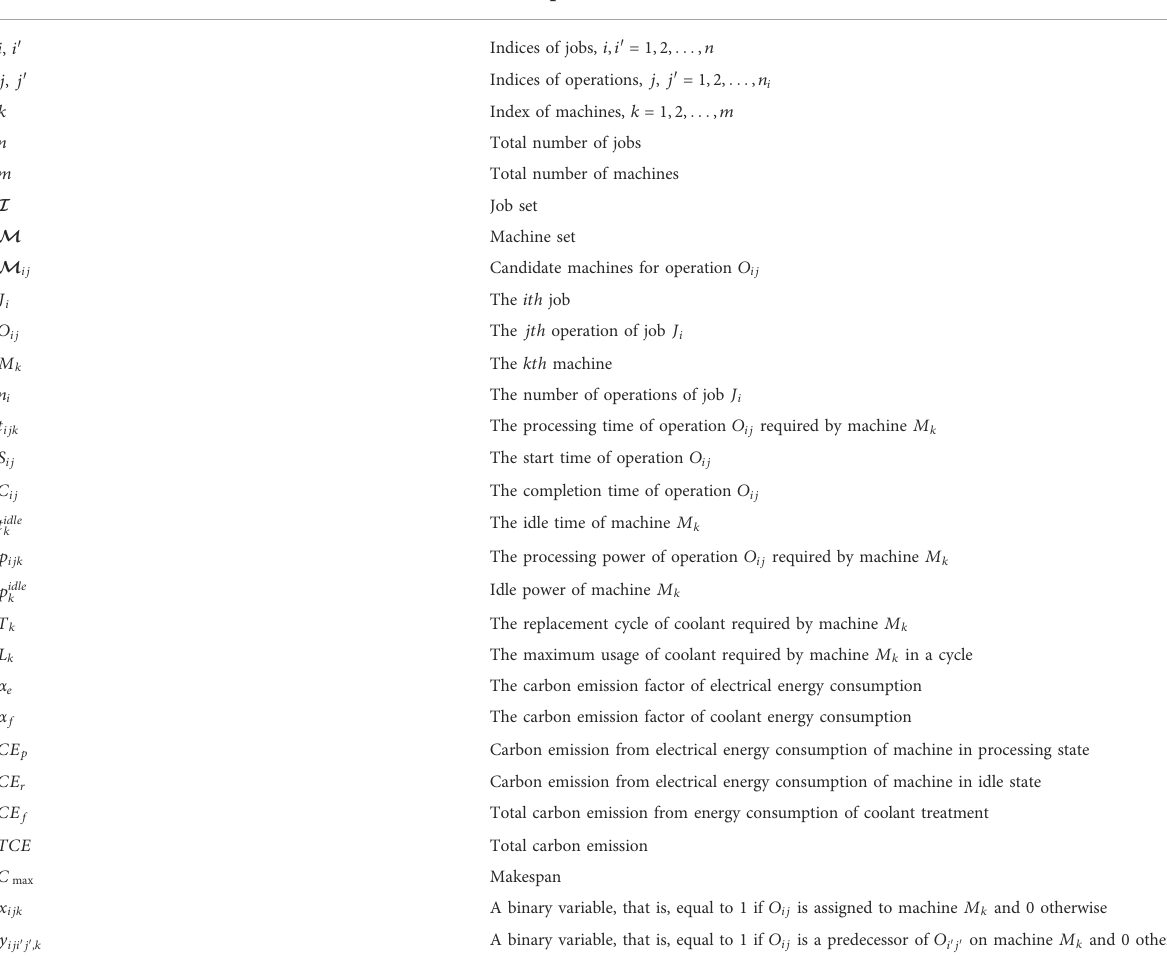
TABLE 1 Notations for